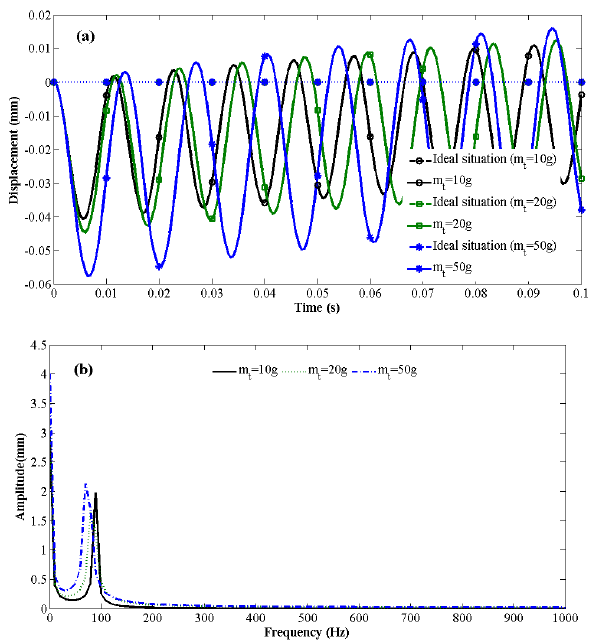
Figure 9. Effect of the end effector on the vibration responses of the MDFMS: (a) response amplitudes and (b) response